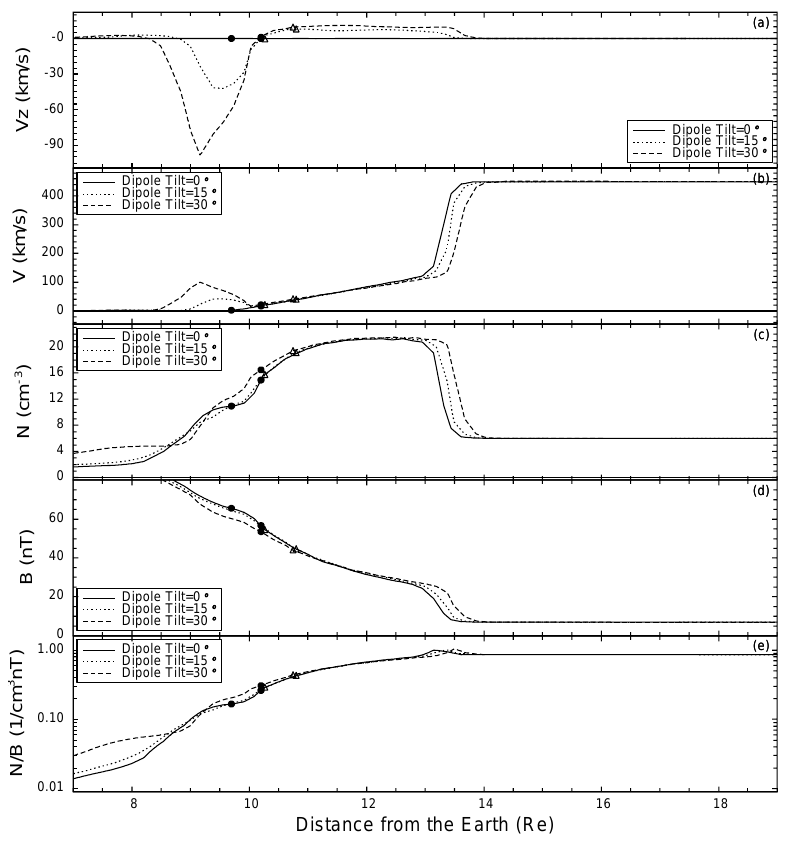
Fig. 14. The plasma V z , the flow speed, the plasma density, the magnetic field magnitude, and the N/B ratio along the Sun-Earth line in Fig. 13. The black dot on each line marks the location of the magnetopause on that line which is de- fined by the close to zero flow velocity or the reverse of V z . The other formats of this figure are the same as those in Fig.